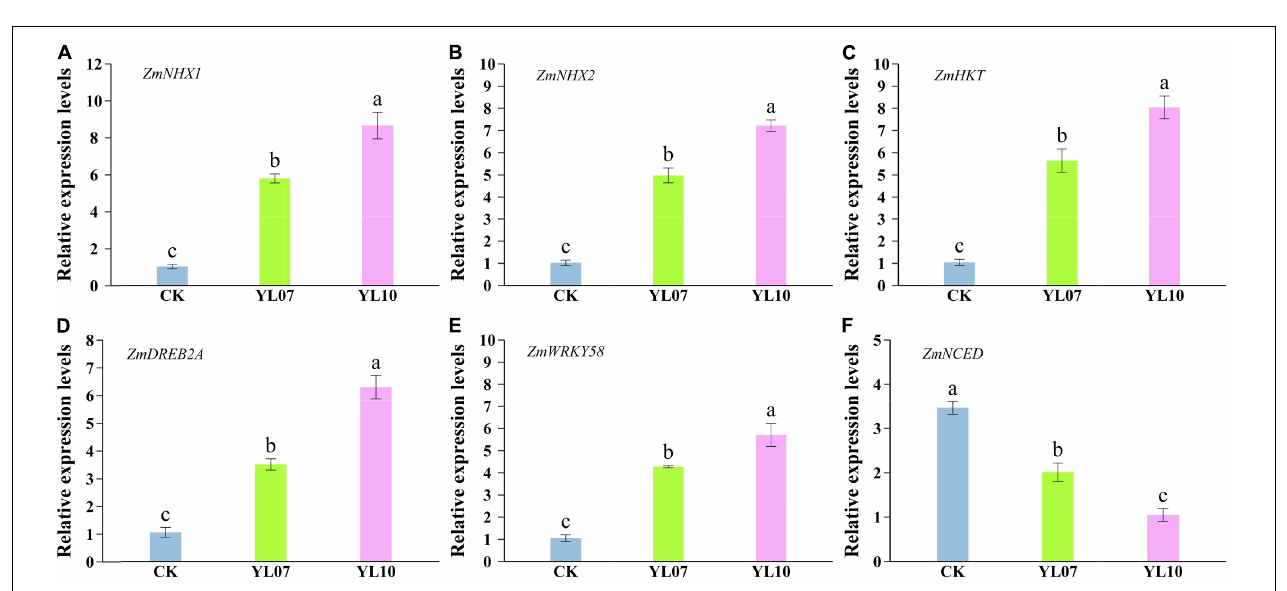
FIGURE 3 | Effect of inoculating with strains YL07 and YL10 on endogenous phytohormone IAA content (A) and ABA content (B) of maize seedlings grown in pots for 31 days under NaCl stress conditions. Different letters indicate significant differences at the P < 0.05 level among the different treatments, as determined by LSD post hoc comparison tests.